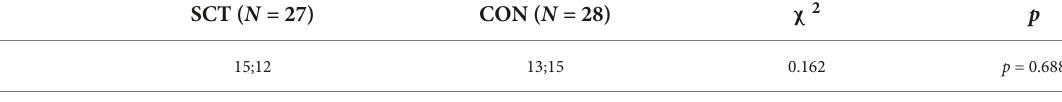
TABLE 3 Results from between-subjects comparisons for both gender (shown as number of men; number of women) and numerical demographic variables (shown as mean ± standard deviation).